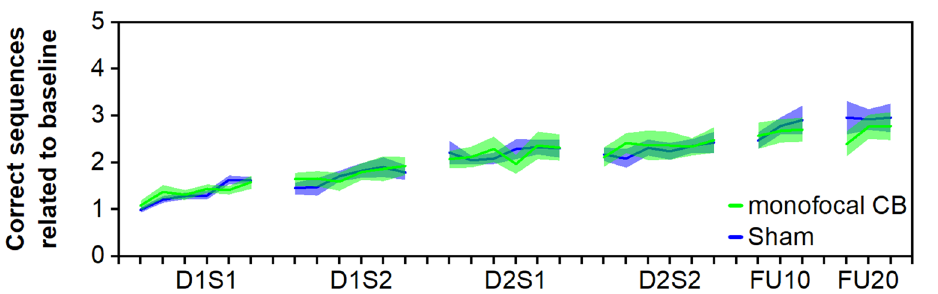
Figure 2. Multisession monofocal CB stimulation. D1S1, day 1 session 1; D1S2, day 1 session 2; D2S1, day 2 session 1; D2S2, day 2 session 2; FU10, circa 10 day follow-up; FU20, circa 20 day follow-up. Margins of error correspond to standard error of the